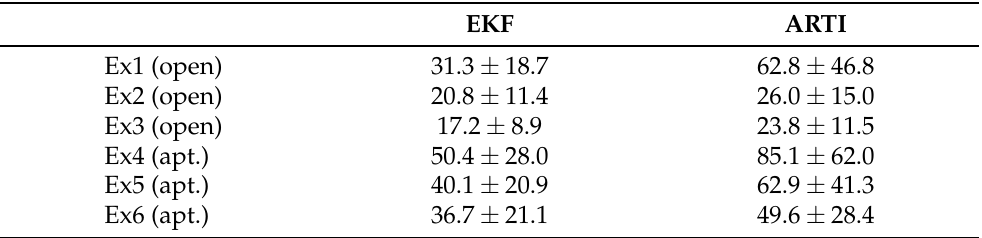
Table 2. DFLT system comparison: RMSE ± standard deviation of the estimation error in